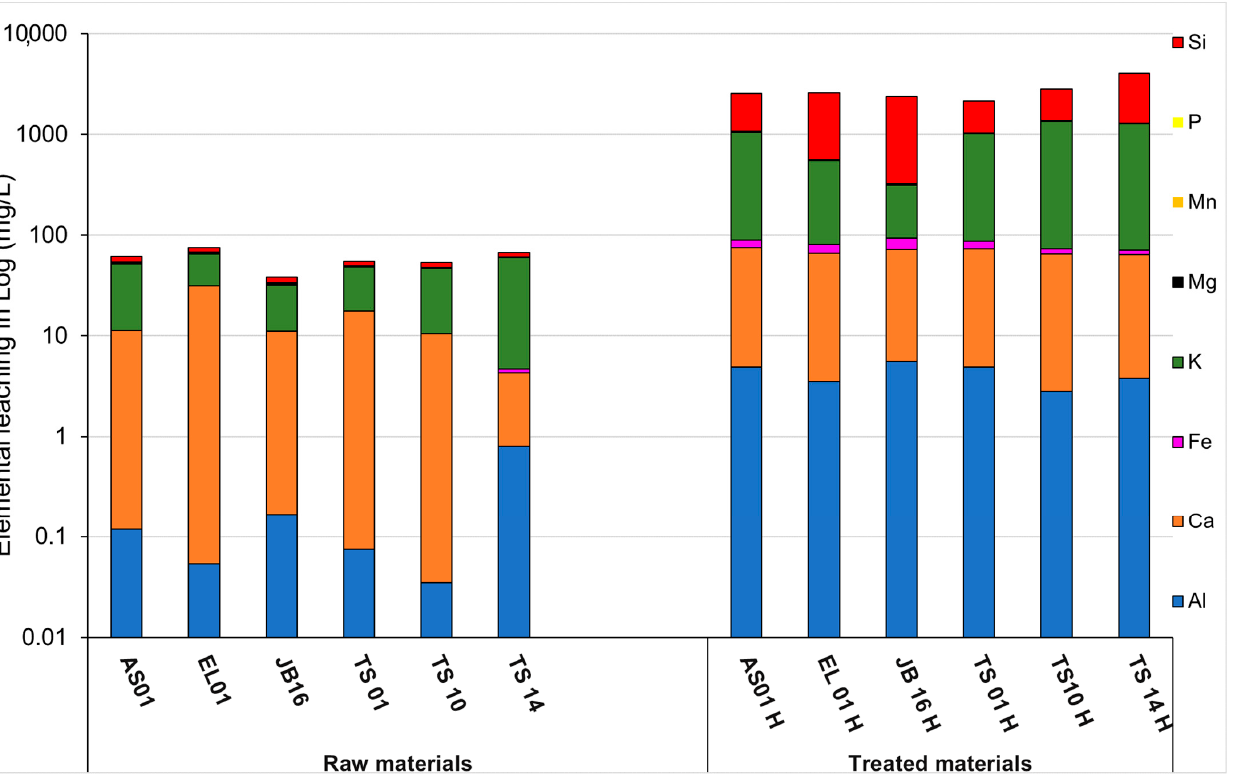
Figure 11. Leaching (mg/L) of the raw and hydrothermal materials after one